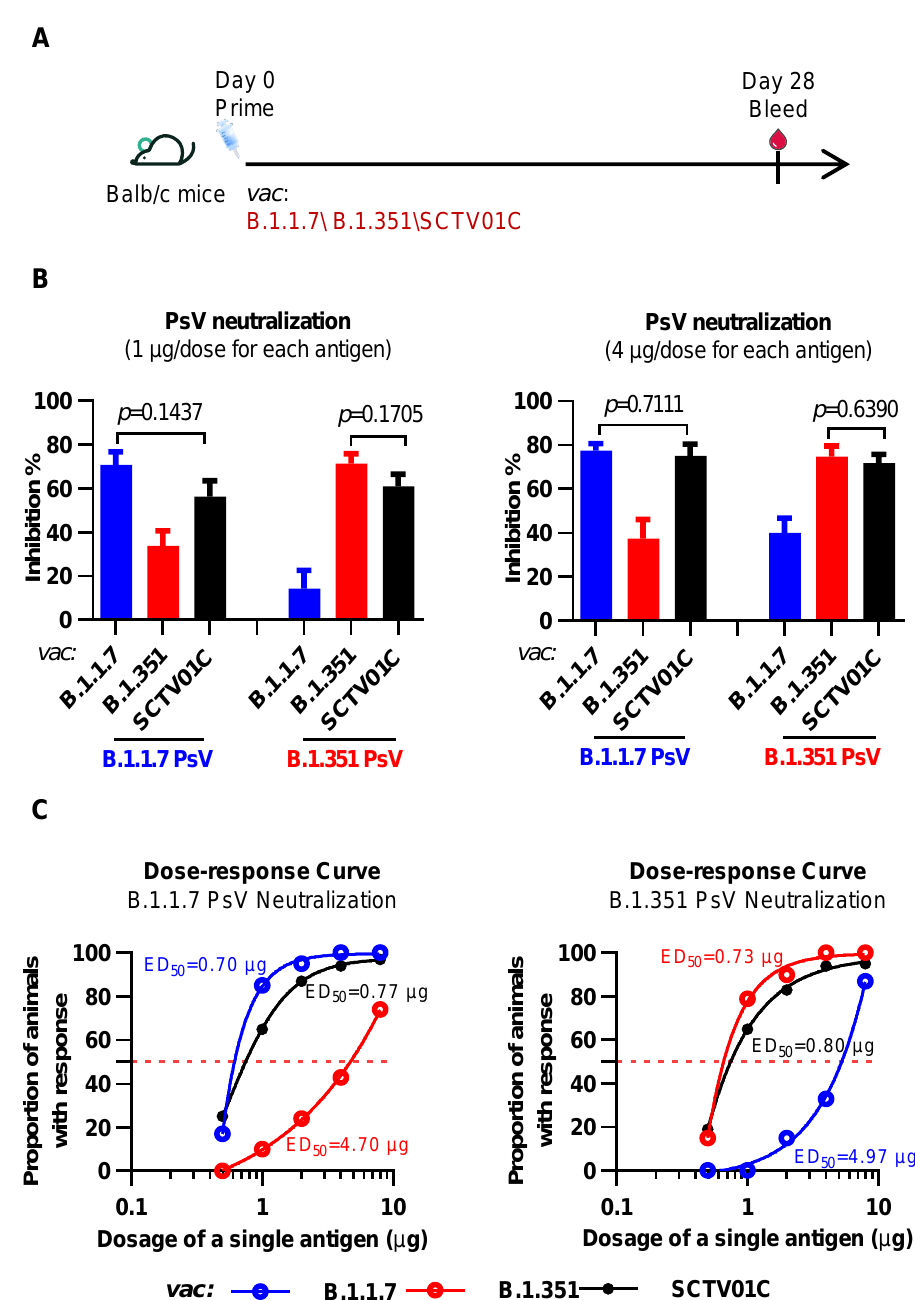
Figure 1. Humoral immune responses induced by the B.1.1.7 monovalent, B.1.351 monovalent and SCTV01C bivalent vaccines after a single-dose immunization. ( A ) Scheme of immunization and serum collection. BALB/c mice (n = 10/group) were immunized with a single dose of B.1.1.7 monovalent vaccine, B.1.351 monovalent vaccine, or SCTV01C on day 0 at five different dose levels (0.5, 1, 2, 4 and 8 µ g for each antigen). Pseudovirus-neutralizing activities of immune sera with a dilution ratio of 1:80 were analyzed on day 28. ( B ) Inhibition rates of immune serum against the B.1.1.7 and B.1.351 PsV were calculated as described in the Materials and Methods section. ( C ) Positive neutralizing antibodies (NAb) were determined as greater than 50% inhibition, and the dose required to achieve this effect in 50% of the animals (ED 50 ) was calculated. The results are representative of 3 independent experiments. Vac is an abbreviation for Vaccine. Bars show mean ± SD. Comparisons were performed by Student’s t test (unpaired,